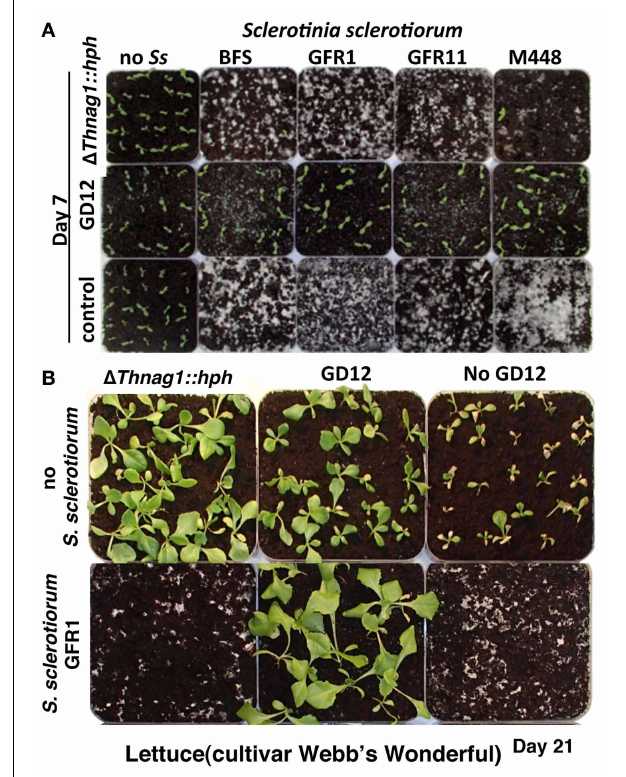
FIGURE 2 | Active biocontrol of the pre-emergence pathogen, Sclerotinia sclerotiorum by T. hamatum, GD12 results in additional plant growth promotion. (A) T. hamatum, GD12 but not the N -acetyl- β -D-glucosaminidase mutant (cid:2) Thnag1::hph is able to suppress S. sclerotiorum and allow germination of lettuce seedlings. Photograph taken 7 days post sowing. (B) Mycoparasitism of Sclerotinia sclerotiorum by T. hamatum, GD12 results in enhanced plant growth promotion, compared to amendment with GD12